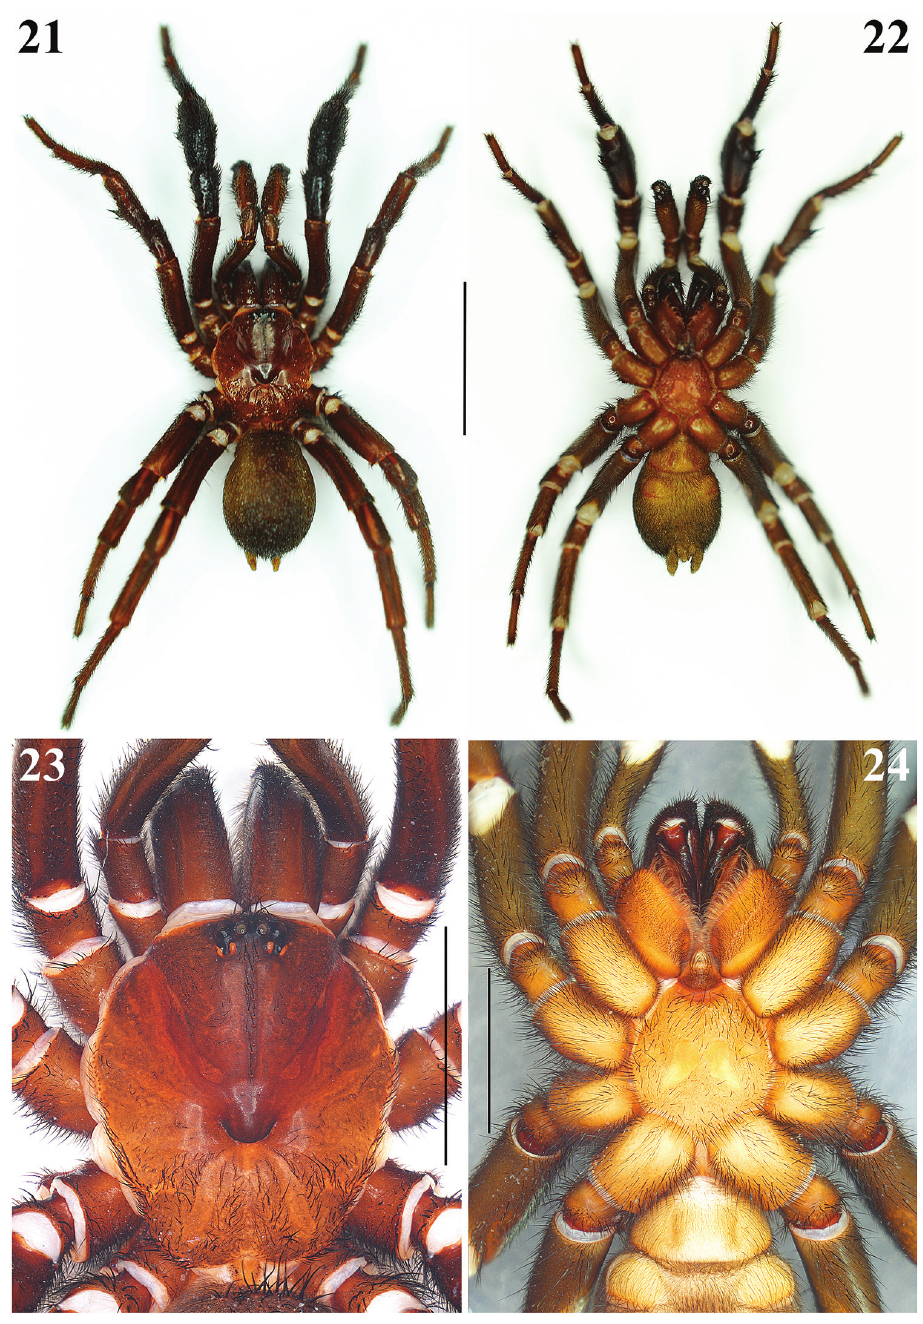
views respectively 23 Carapace, dorsal view 24 Prosoma, ventral view showing coxae, sternum, labium, and endites. Scale bars 0.5 mm ( 23 , 24 ), 1 mm ( 21 , 22